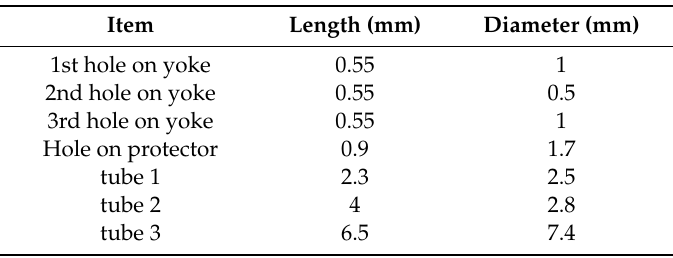
Table 3. Parameters of holes and